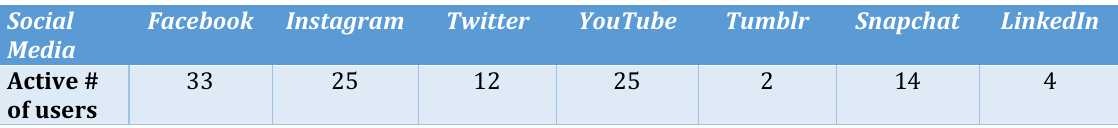
Table 5: Social Media